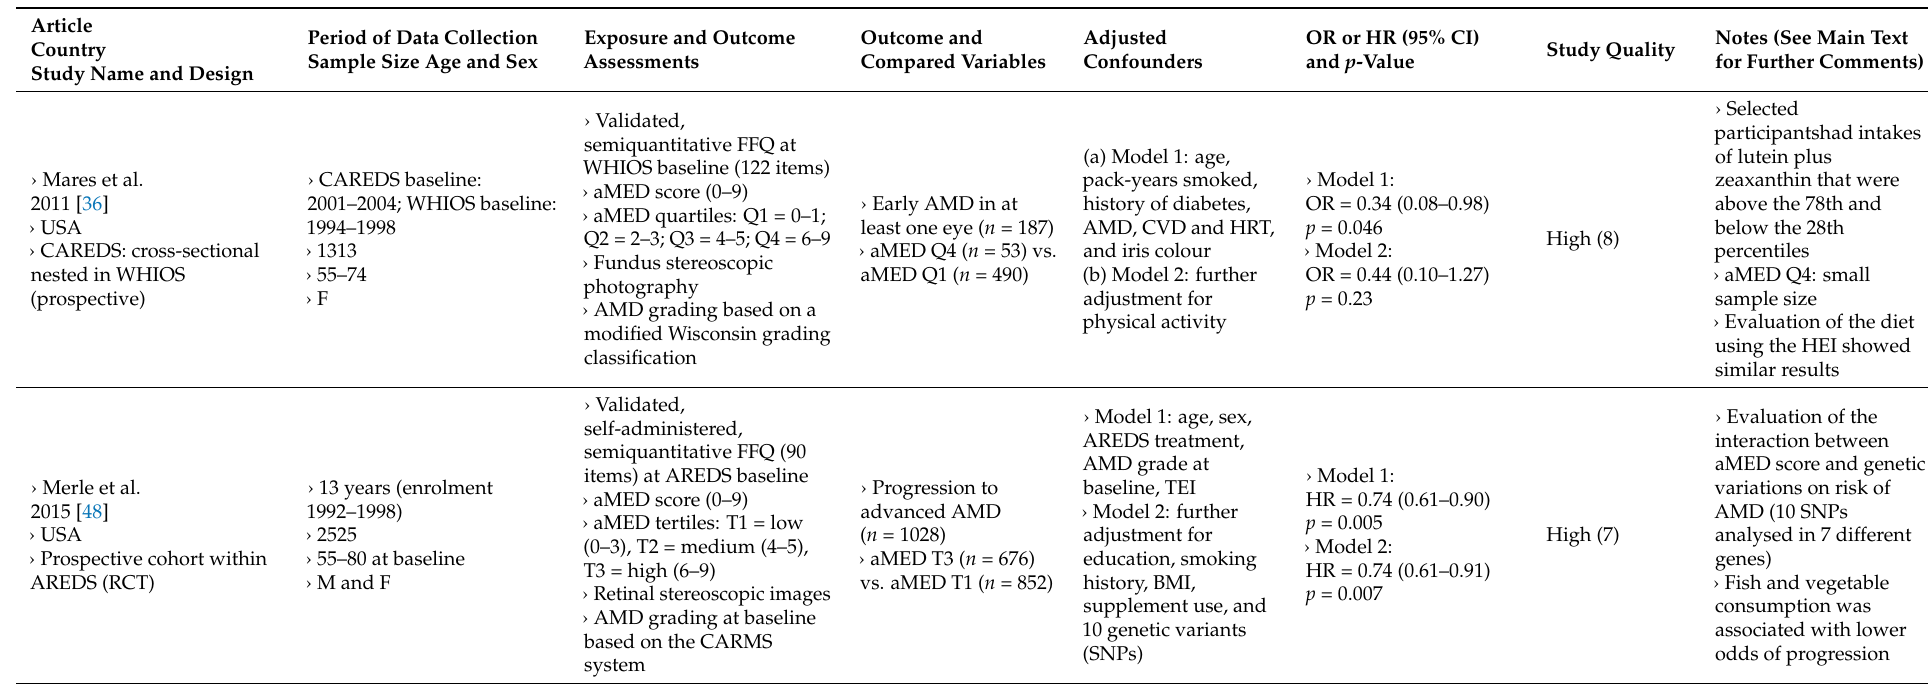
Table 1. Characteristics of the eight studies included in this review evaluating the association between the Mediterranean diet and